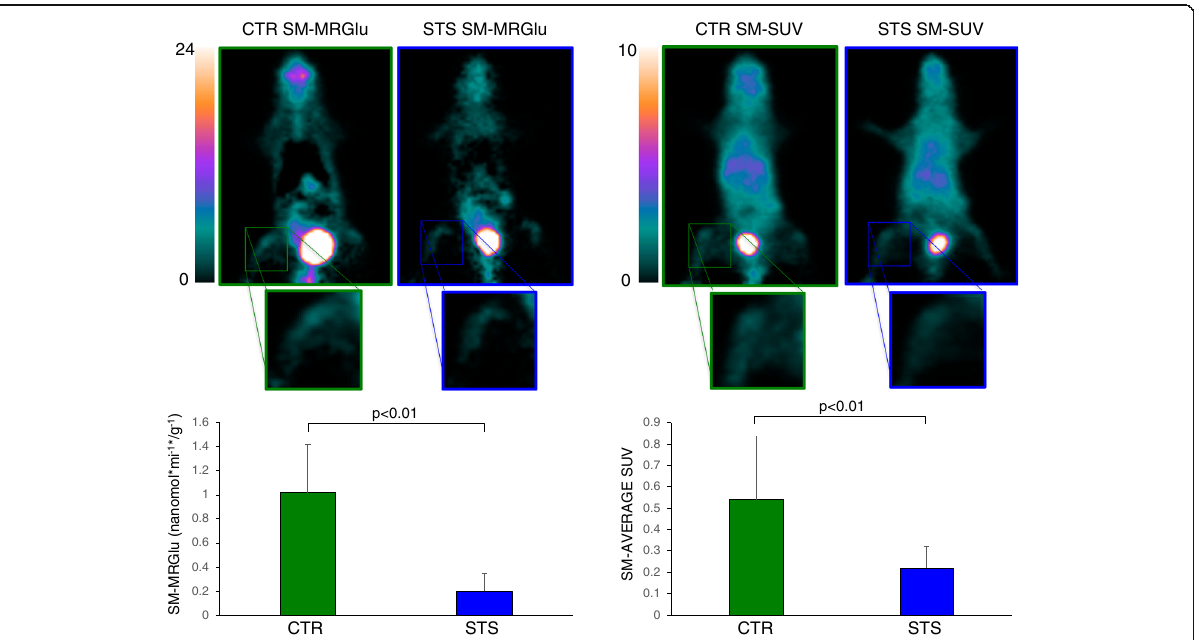
Fig. 2 In vivo effect of STS on skeletal muscle metabolism. In the upper part, on the left, skeletal muscle parametric maps of representative control (CTR) and 48-h starved (STS) mice are shown; representative images of basal metabolic activity of hind limbs skeletal muscle expressed in average standardized uptake value (SUV) are shown on the right. In the bottom, graphs of hind limbs skeletal muscle metabolic rate of glucose (SM-MRGlu*; nmol × min − 1 × g − 1 ) and SUV are displayed, respectively. Results indicate mean ± SD of nine mice per group; green bars represent control value, and blue bars represent STS